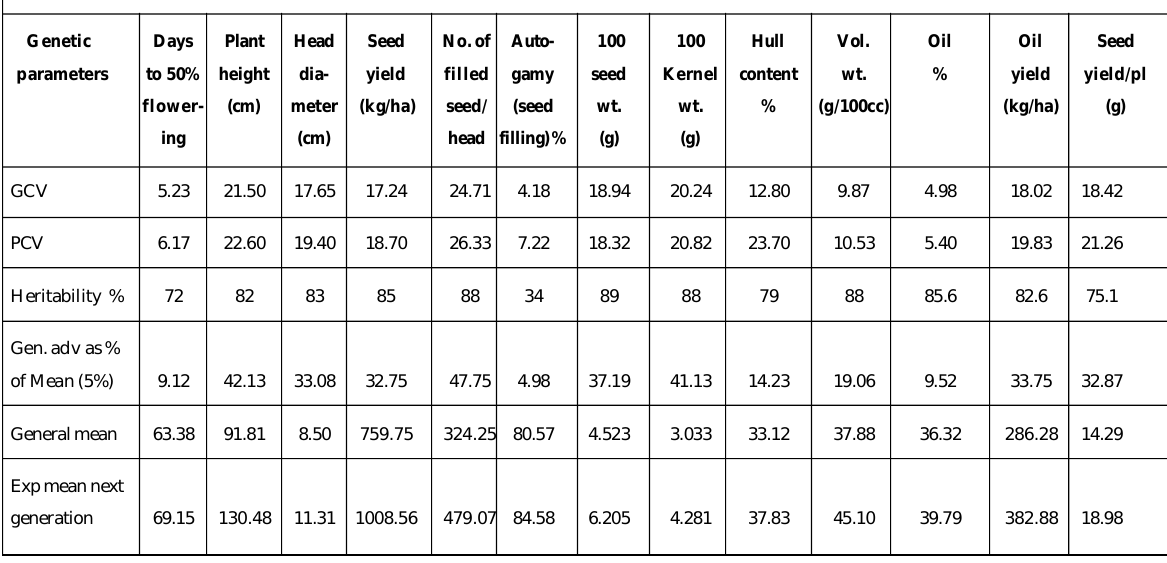
Table 3: Estimations of phenotypic and genotypic coefficients of variability, heritability, genetic advance and mean for yield attributing traits in sunflower germplasms Genetic Days Plant Head Seed No. of Auto-